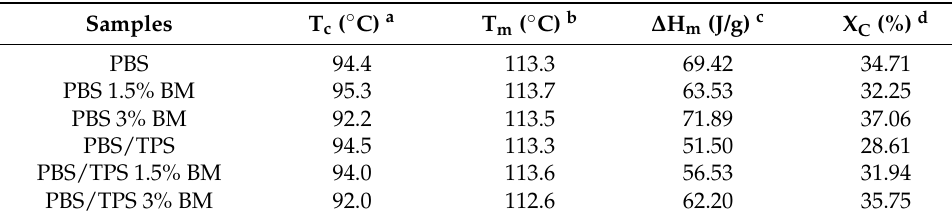
Figure 4 Figure 4. DSC spectra of PBS films. Table 3. DSC data of PBS